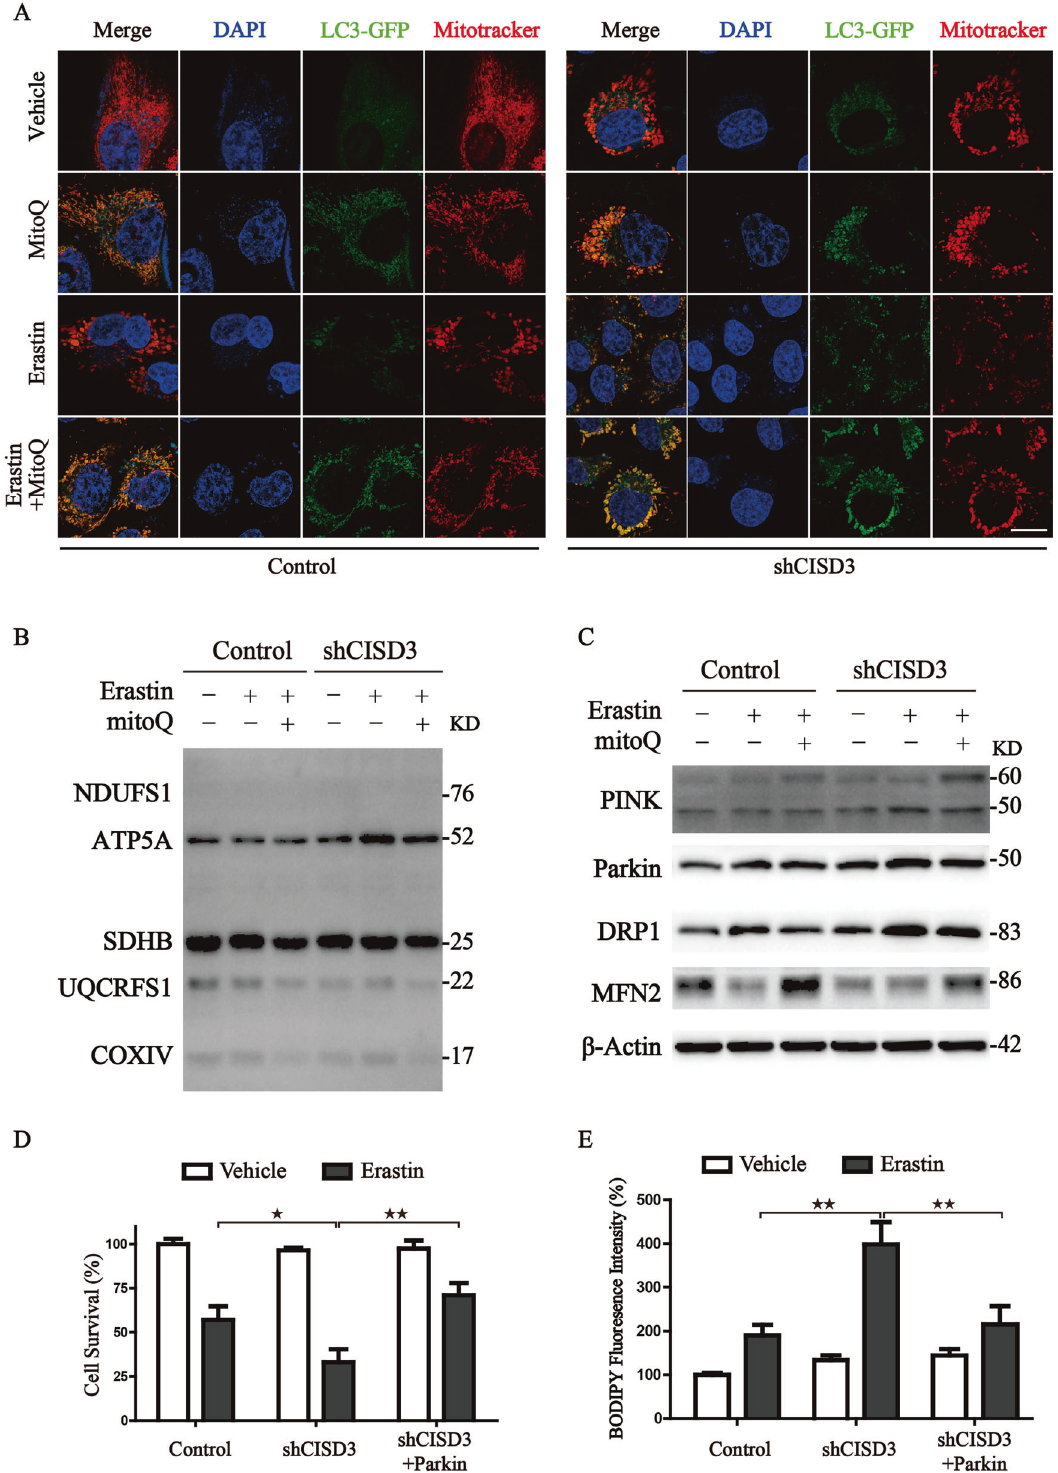
Fig. 6 MitoQ ameliorates CISD3 associated ferroptosis via regulation mitophagy and the process of mitochondrial dynamics. A Cells were transfected with LC3-GFP, after indicated treatment (7.5 µM erastin; 0.5 µM mitoQ) for 4 h, cells were co-stained with Mitotracker. The images were taken by a laser confocal microscope. Scale bar: 10 μ m. B, C Protein levels were analyzed by western blot in control and shCISD3 cells with the designed treatment. β -actin served as the loading control. D Cell viability was assayed using CCK8 kit in the indicated cells with or without 7.5 µM erastin treatment for 12 h. E Lipid peroxides were assayed by BODIPY staining in the indicated cells with or without 7.5 µM erastin treatment. * P < 0.05, ** P < 0.01 versus control or between different groups.